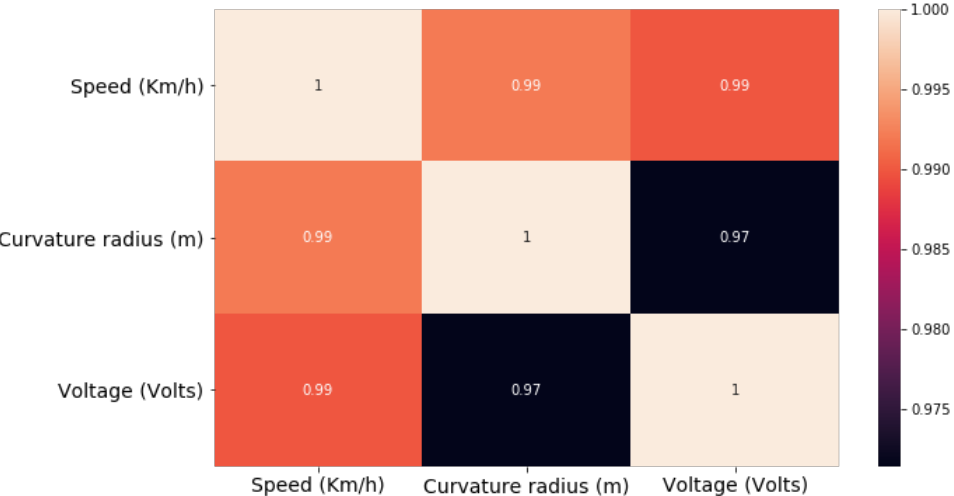
Figure 9. Pearson correlation between speed, voltage, and curvature variables.